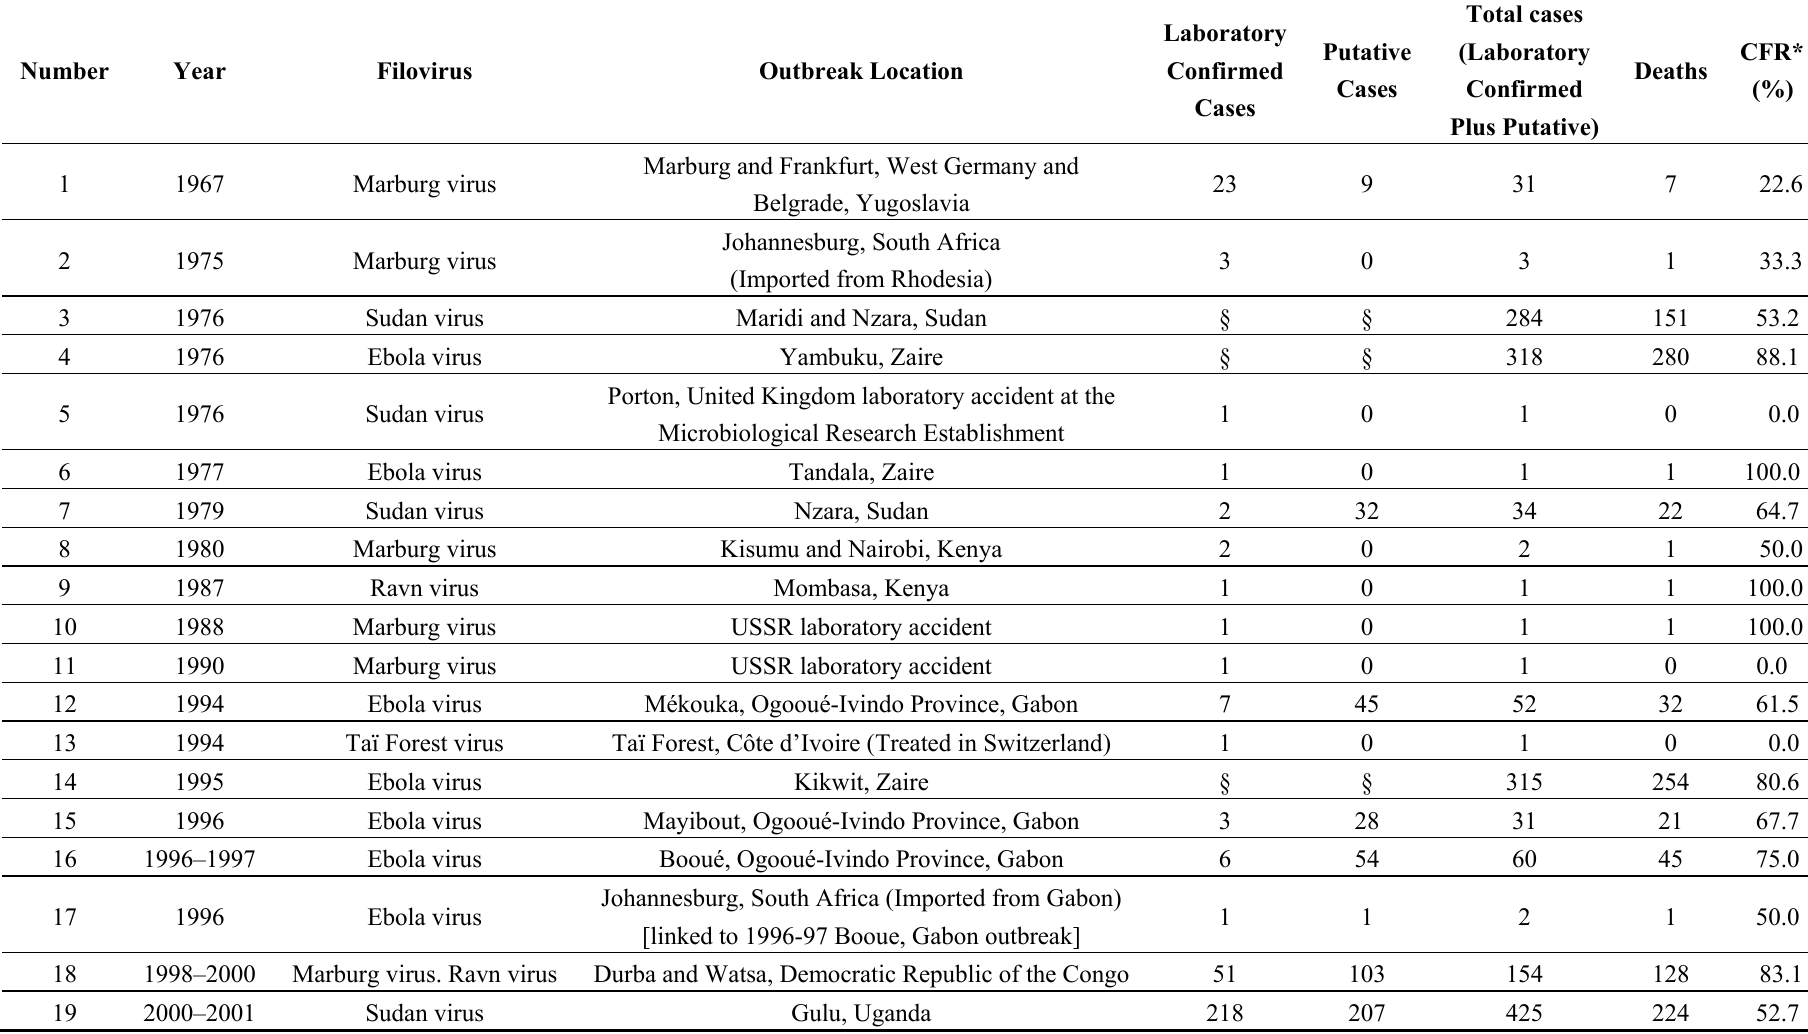
Table 1. Recognised and declared filovirus-disease outbreaks in humans (1967–18 September 2014). Note: Biosafety level-4 laboratory accidental exposures are categorized as filovirus-disease outbreaks as they involve human